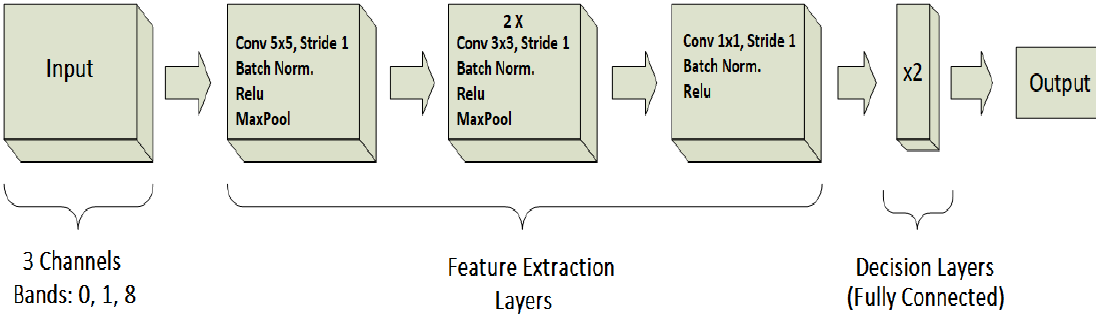
Figure 7. The CloudScout model block